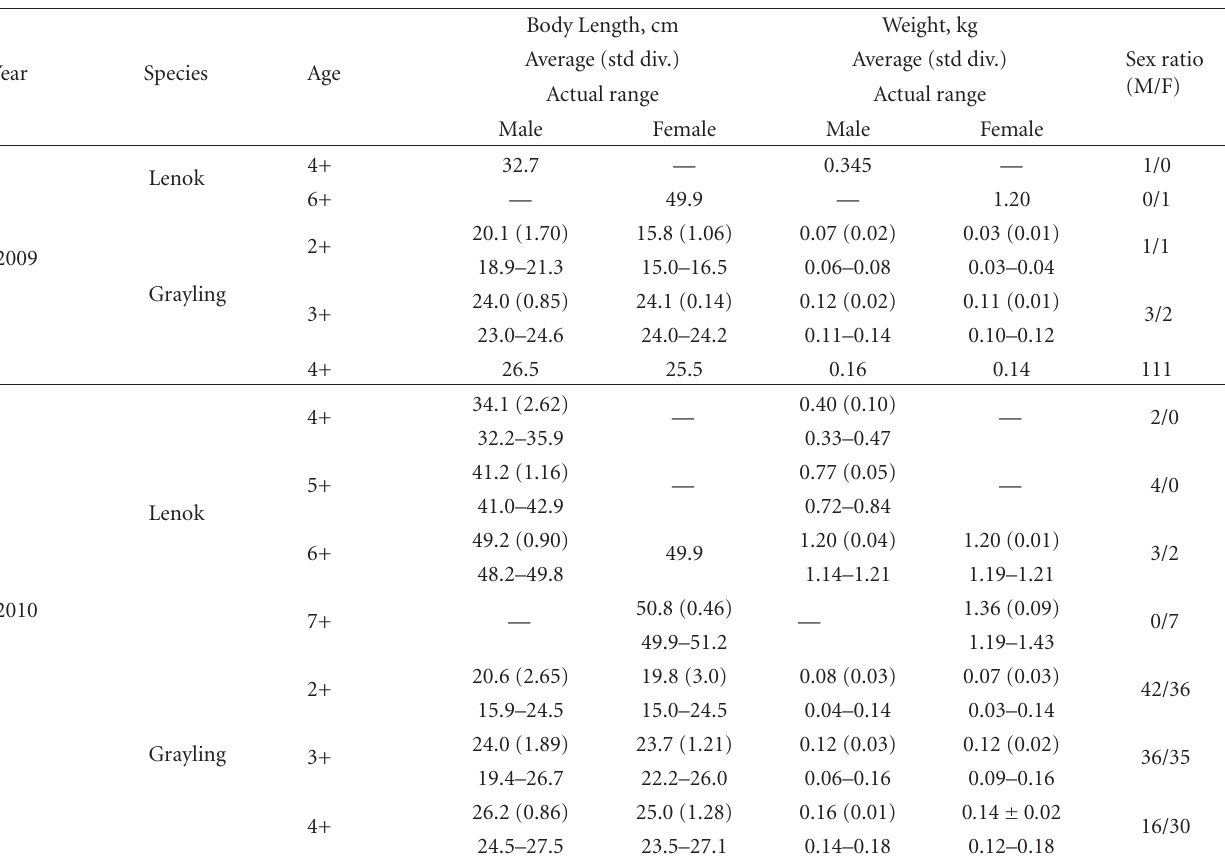
Table 2: The size-weight characteristics of infected fishes in 2009 and 2010.